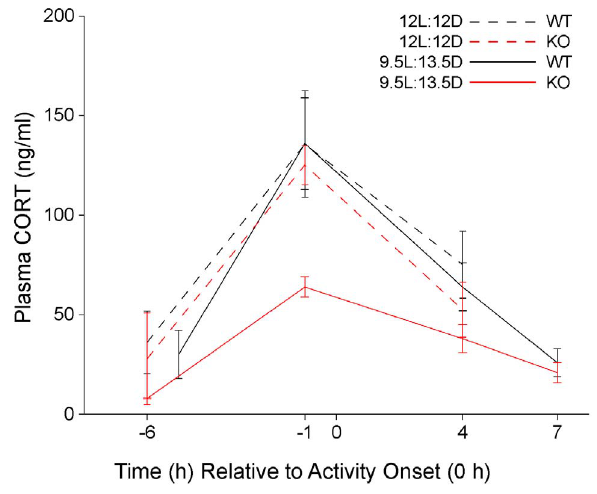
Figure 2. Plasma CORT levels of wild type and 5-HT 1B knockout mice in 12L:12D conditions. Circulating CORT values of wild type (WT) and 5-HT 1B knockout (KO) animals, sampled at three time points under 12L:12D conditions, exhibited a diurnal rise with peak CORT values at 2 1 h. CORT values of WT and KO mice were similar at each of the time points sampled. The 2 6 h and + 4 h time points were significantly less than 2 1 h time point (p , 0.05) (4–7 animals/time point; shaded region represents dark).